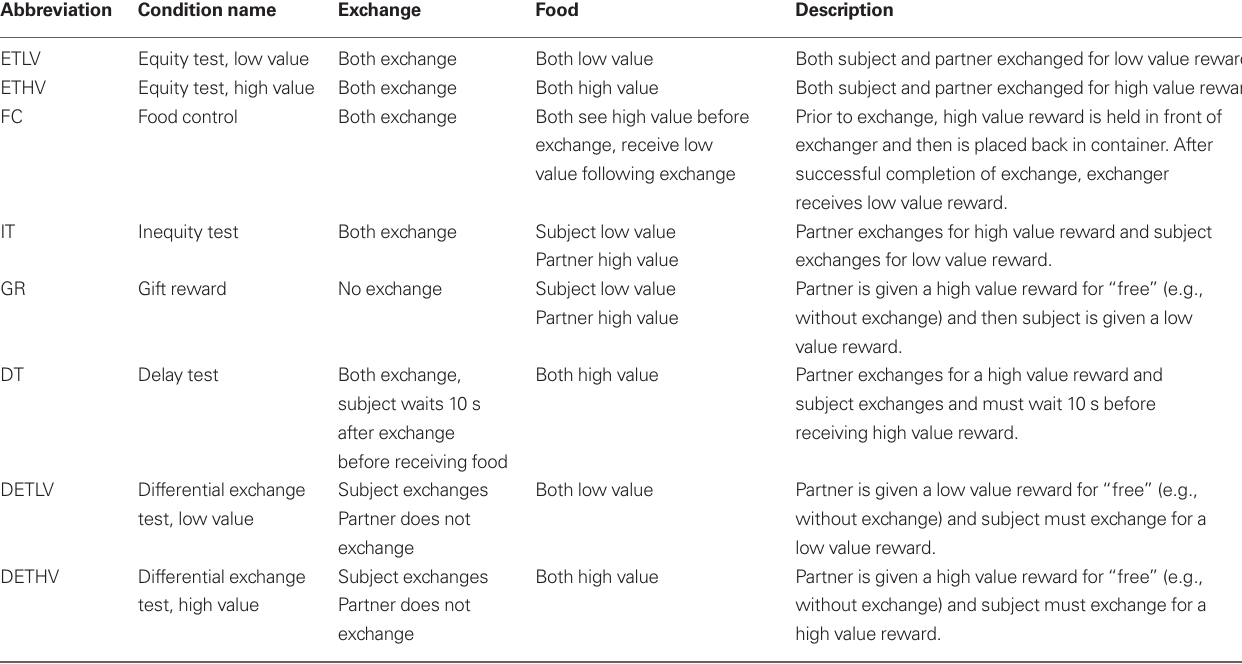
Table 1 | Description of experimental conditions (for a summary of the procedure, see Figure 1 and associated